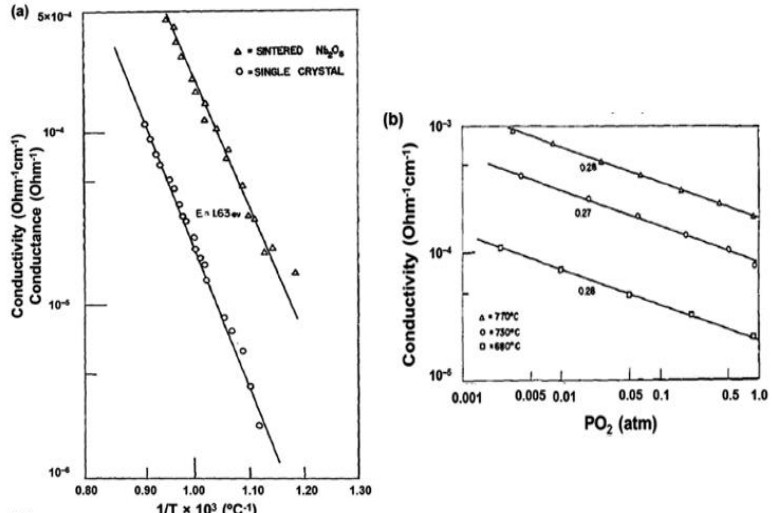
Figure 3. ( a ) The electrical conductivity of the sintered a-Nb 2 O 5 together with the electrical conductance of Nb 2 O 5 single crystal against 1 / T for the specimens heated in air. ( b ) The electrical conductivity of the sintered a-Nb 2 O 5 against the partial pressure of oxygen [63,81]. Reprinted with permission from [81]. Copyright 1961 AIP Publishing.